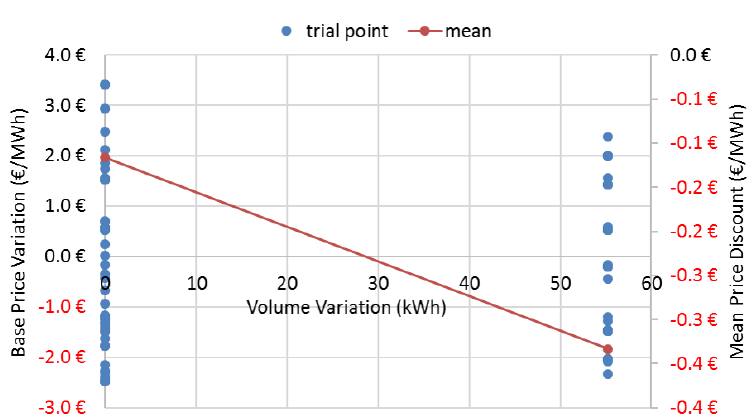
Figure 3. Retailer response to the consumption variation of the consumer in the base period.